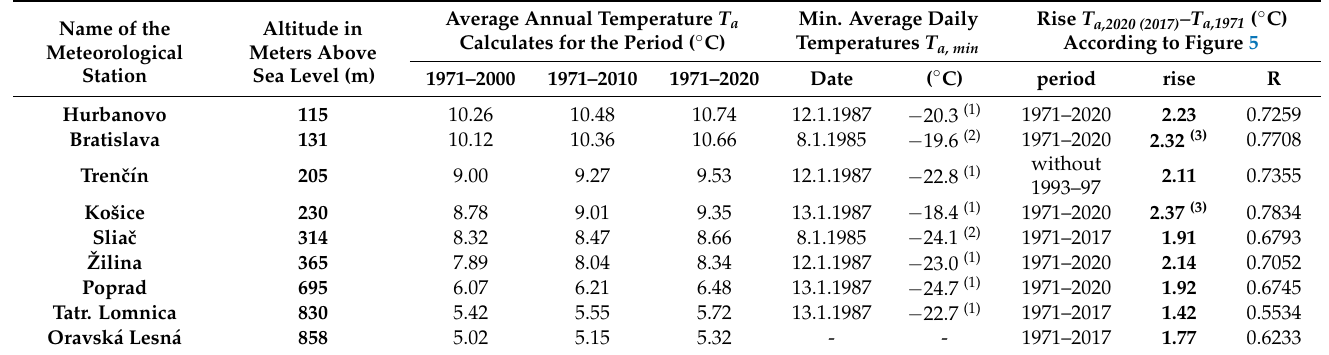
Table 2. Average annual temperature T a calculated for the periods 1971–2000, 1971–2010, and 1971–2020 and Rise T a,2020 (2017) – T a,1971 ( ◦ C) according to Figure 5.